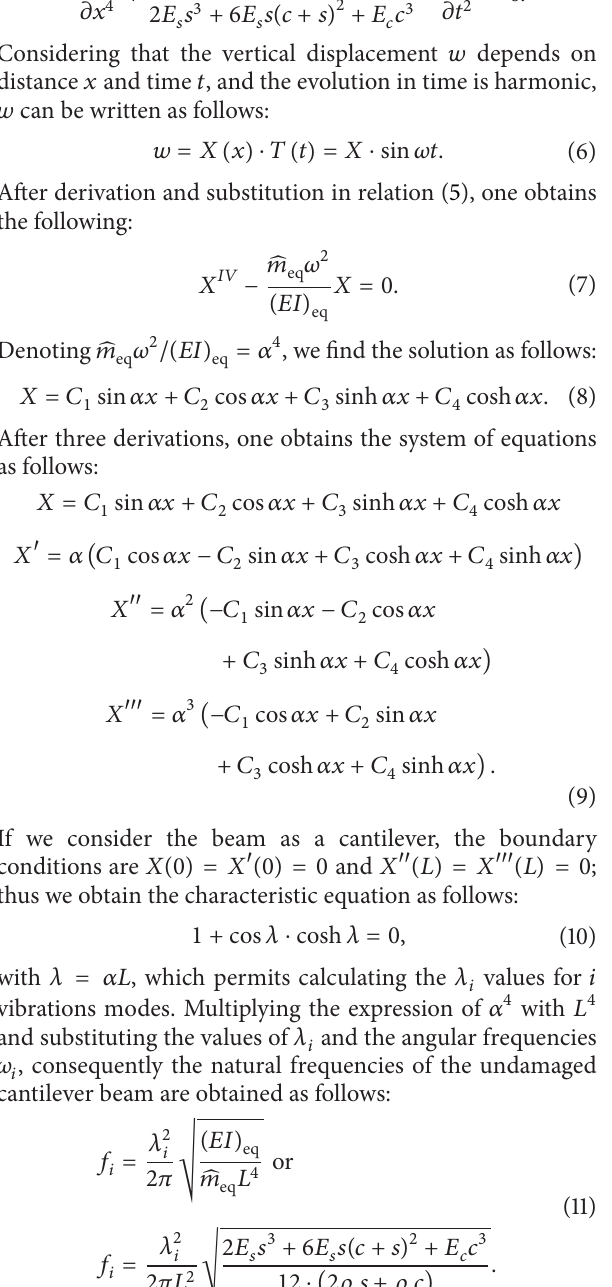
Figure 1: Sandwich beam with three